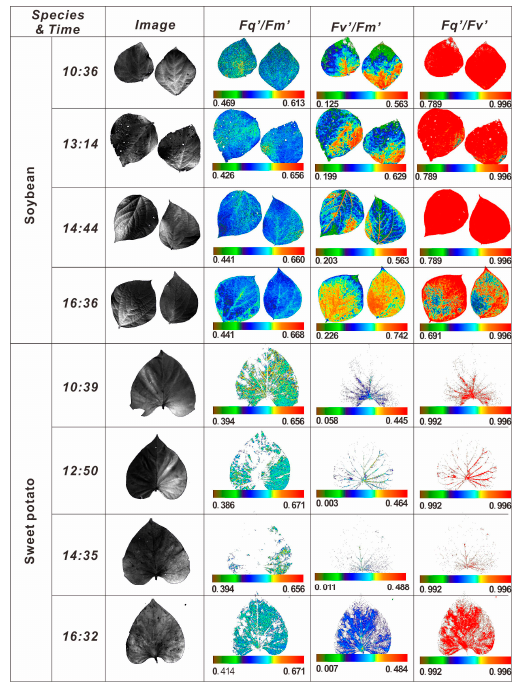
Figure 7. Diurnal patterns of Fy760 accompanied by the photosynthesis parameters and gas exchange measurements. The upper panel shows the soybean results, and the lower panel shows the sweet potato results. Images of (cid:1832) (cid:3044)(cid:4593) /(cid:1832) (cid:3040)(cid:4593) (PSII operating efficiency), (cid:1832) (cid:3049)(cid:4593) (cid:1832) (cid:3040) ′ ⁄ (PSII maximum efficiency), and (cid:1832) (cid:3044)(cid:4593) (cid:1832) (cid:3049) ′ ⁄ (PSII efficiency factor) were from soybean and sweet potato.